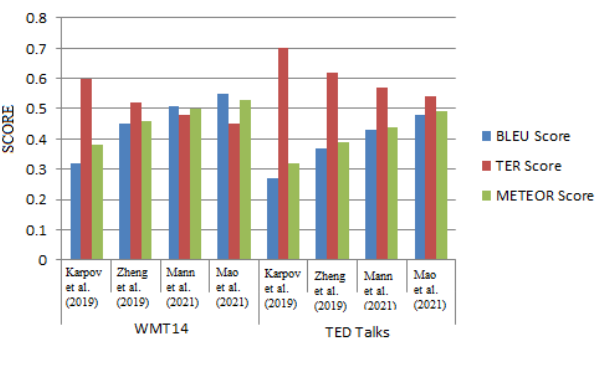
Figure 8. A comparative analysis